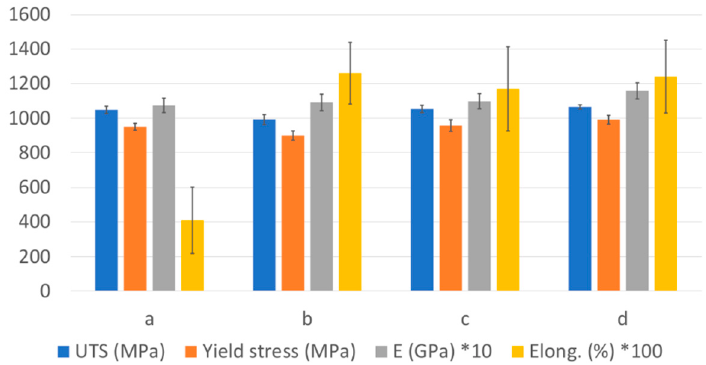
Figure 12. Tensile properties of a – d samples.